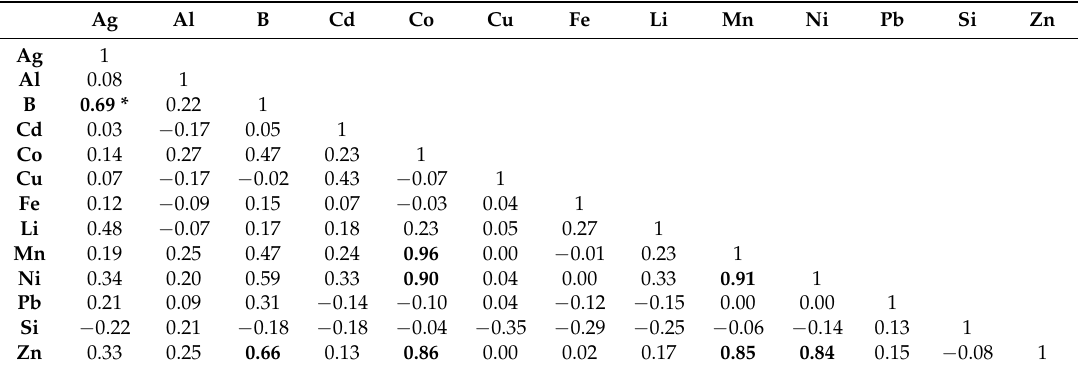
Table 8. Correlation among metals in groundwater.